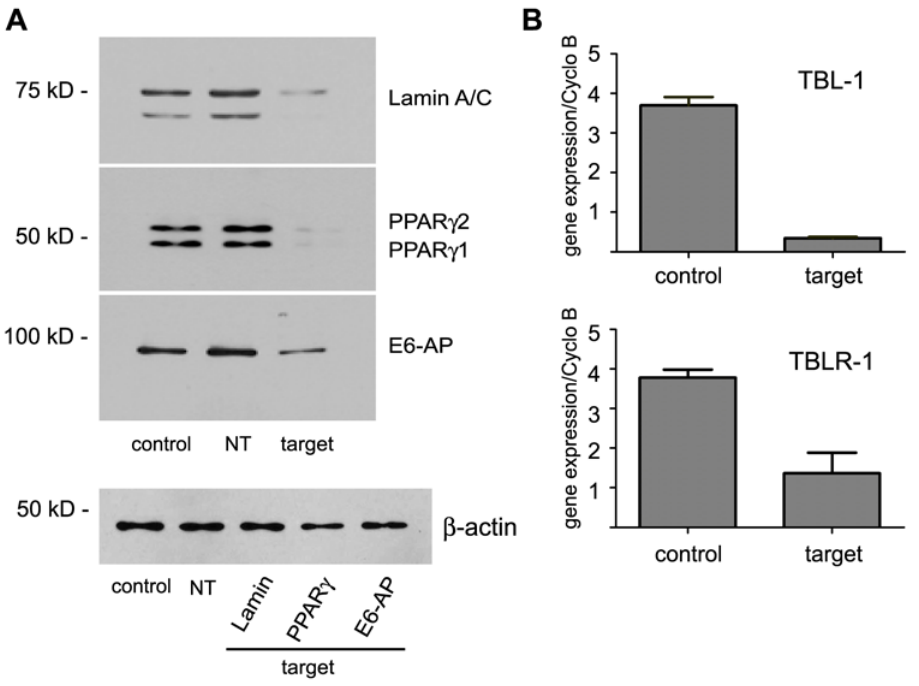
Figure 5. Specific genes are efficiently targeted with lipid-based siRNA transfection of adipocytes. Knockdown of specific genes was assayed at 48 hours post-transfection using either the RISC-free control siRNA (control), nontargeting siRNA (NT), or siRNA targeted to the indicated gene (target). (A) Thirty-five m g of protein was loaded in each lane and separated by SDS-PAGE. Knockdown of lamin A/C, PPAR c 1 and PPAR c 2, and E6-AP was assayed via western blot analysis. Equal loading of each lane was determined using b -actin expression. (B) knockdown of TBL-1 and TBLR-1 was assayed via real-time PCR in triplicate and reported as the mean and standard deviation. These experiments were carried out independently greater than four times.